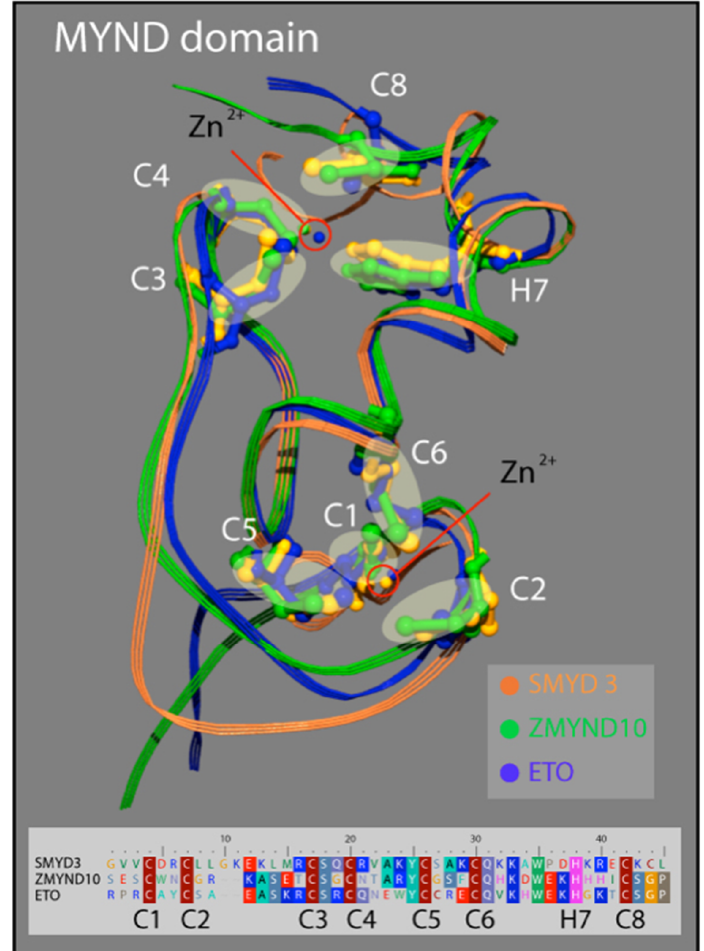
Figure 5. Structure of the MYND domain. A ribbon representation of the secondary structure for the MYND domain of SMYD3 (orange) is superimposed on the MYND domains of ZMYND10 (green) and ETO (blue). An insert shows a sequence alignment for the MYND domains of these three proteins. The seven invariant cysteine residues (red) and the invariant histidine (pink) are included.